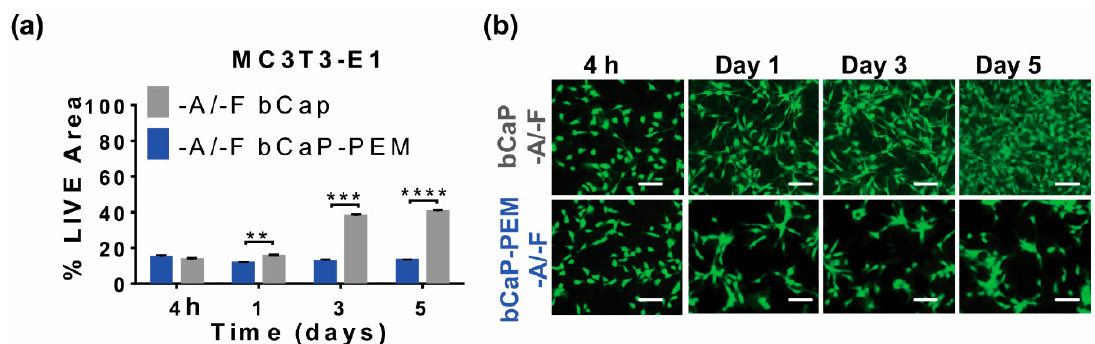
Figure 4. MC3T3-E1 osteoprogenitor cells cultured on bCaP coating or bCaP-PEM without any factors to examine the biocompatibility of the biomaterial coatings. ( a ) Percent of LIVE ® stained area of MC3T3-E1s on bCaP (24 h) ( − A/ − F) vs. bCaP (24 h)-PEM ( − A/ − F), and ( b ) fluorescent LIVE ® stained images of MC3T3-E1 cells on bCaP (24 h) and bCaP (24 h)-PEM. Scale bar = 100 μ m.